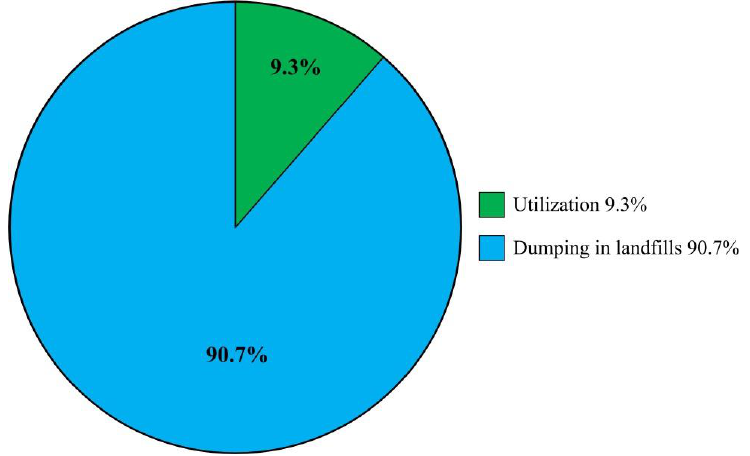
Figure 2. Municipal solid waste (MSW) recovery structure in Russian Federation [3].